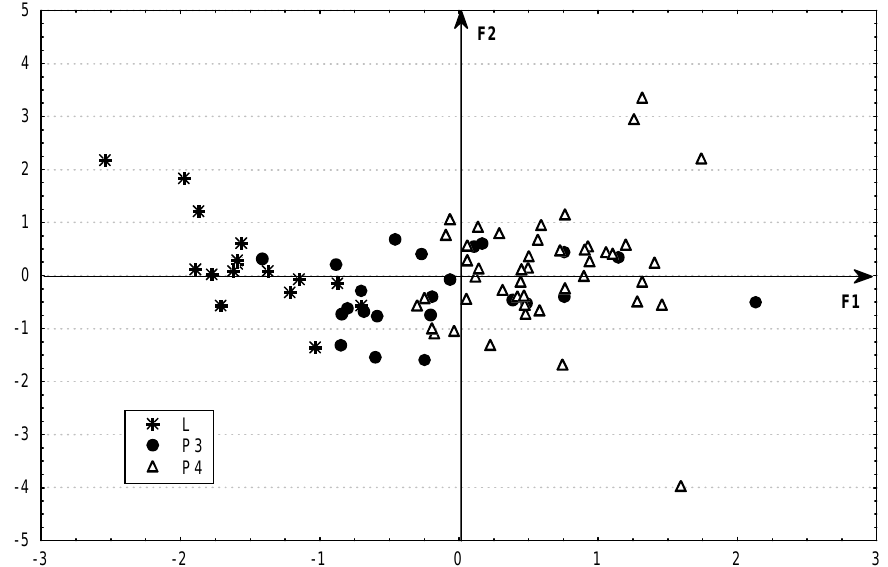
Figura 2. Agrupamento das bacias hidrográficas de 2. a ordem de magnitude, de acordo com a análise de fatores. L: Latossolo Vermelho, P3: Argissolo Vermelho-Amarelo relevo suave ondulado e P4: Argissolo Vermelho-Amarelo relevo